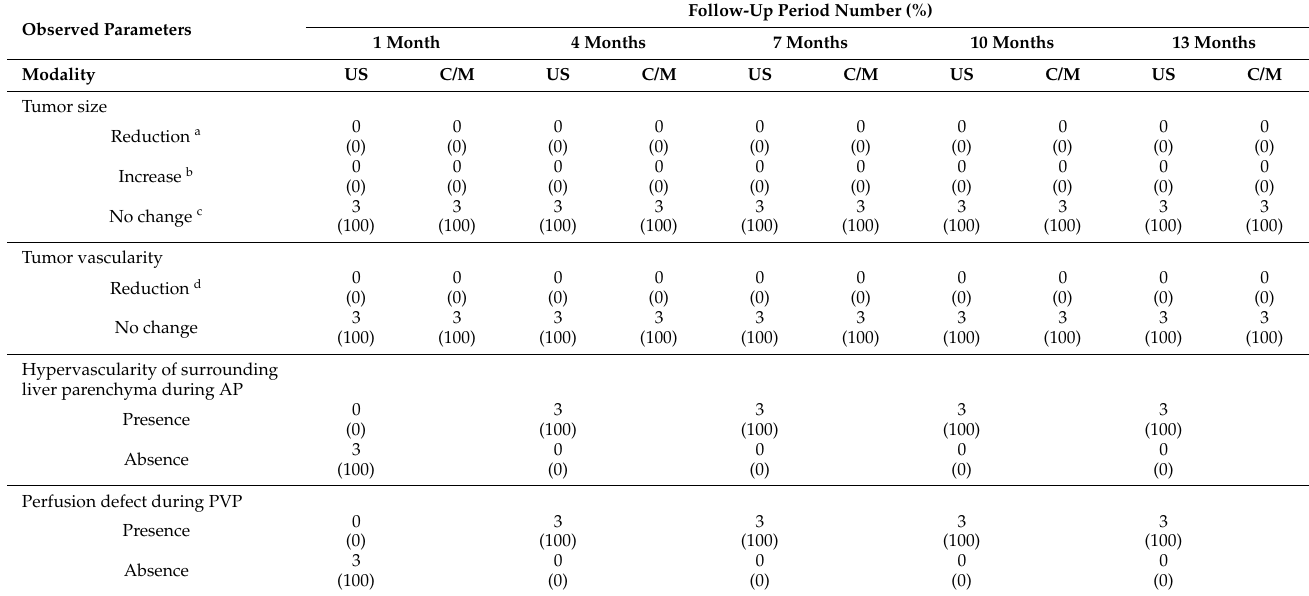
Table 3. Changes in SCEUS and CECT/CEMRI findings during 13 months after RT for local recurrence cases (N = 3). Observed